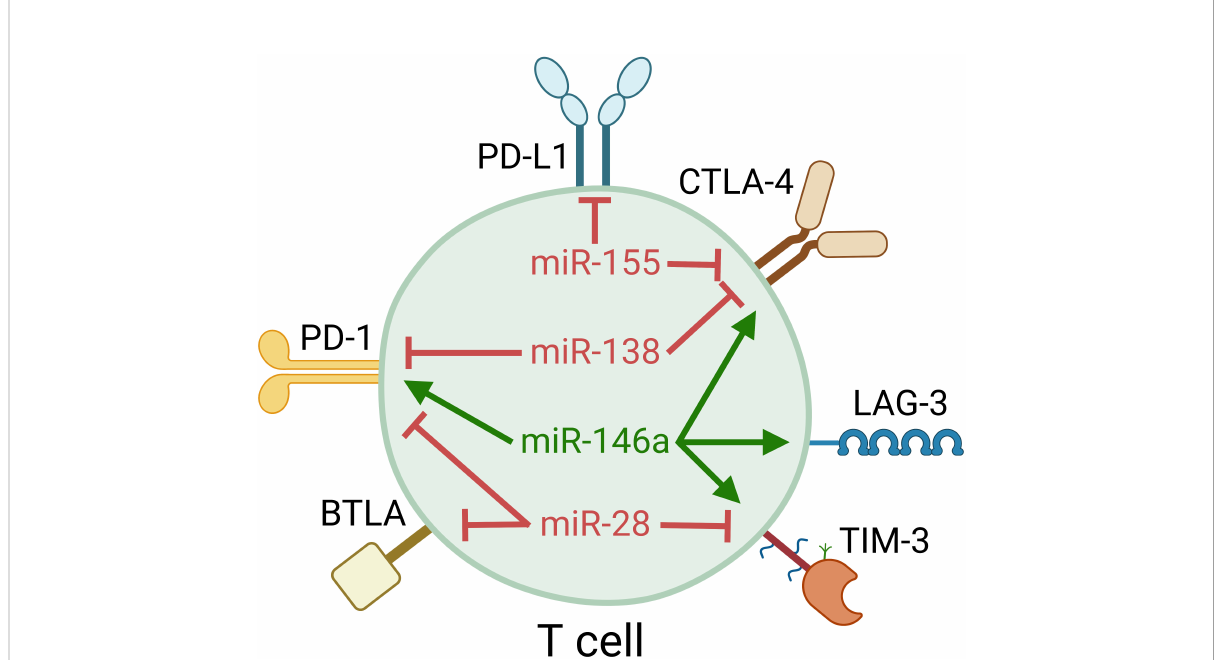
FIGURE 2 miRNAs regulate T-cell inhibitory checkpoint molecules many of which are targets of clinical immune checkpoint blockade. Each miRNA can target multiple checkpoint molecules, providing a novel tool to target multiple nonoverlapping